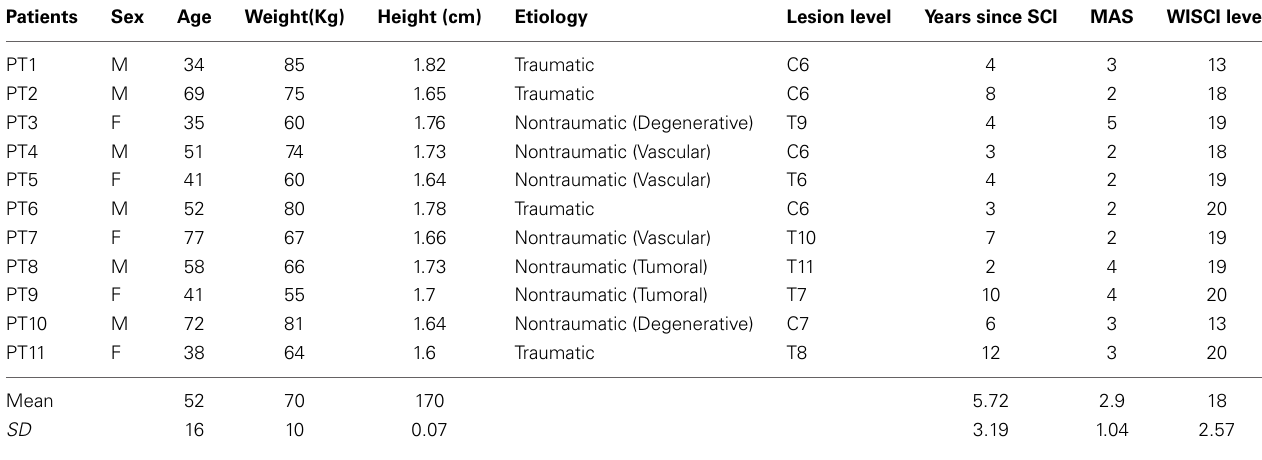
Table 1 | Patients’ clinical and epidemiological data.